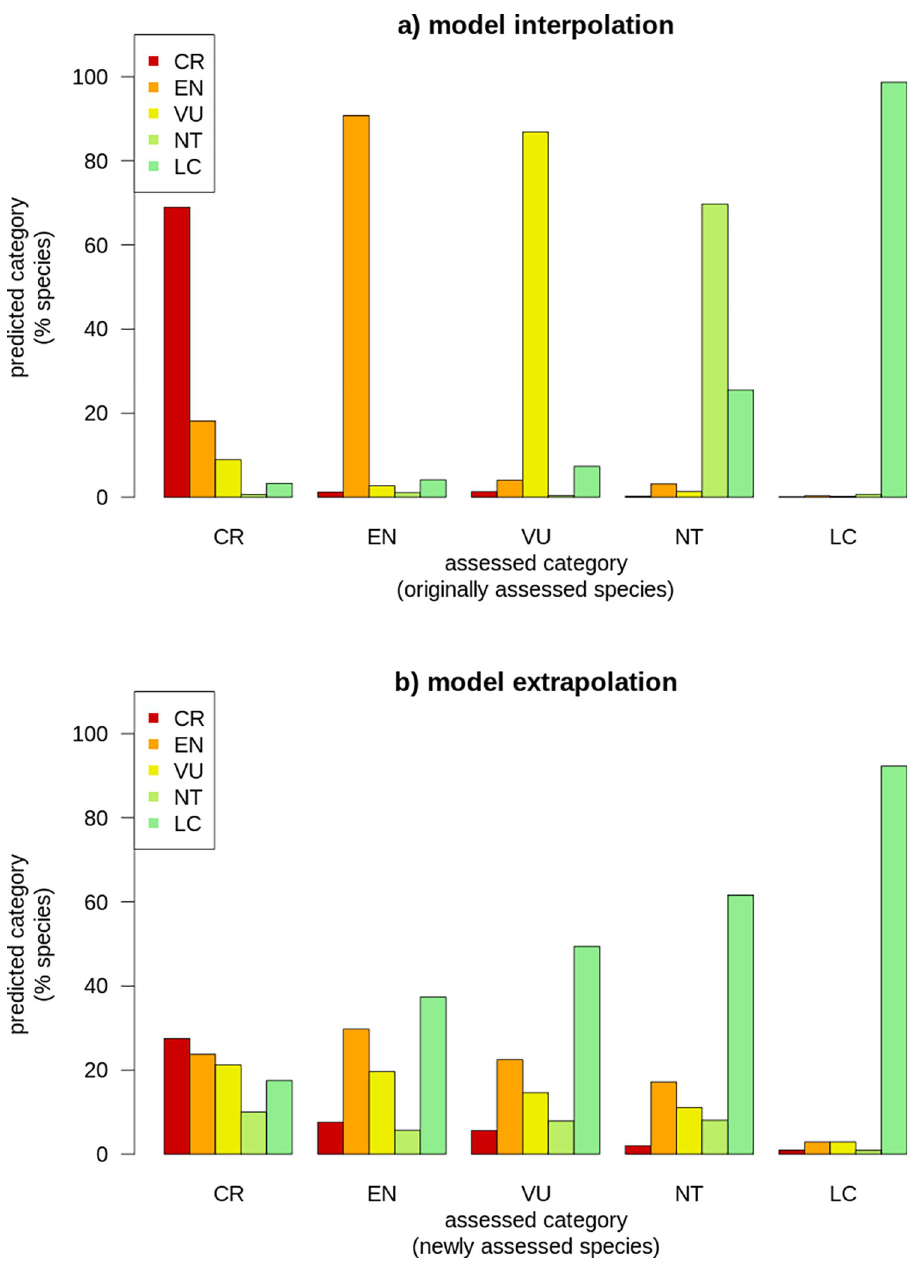
Fig 1. Comparison between the performance of the automated assessment model presented in [6] during interpolation and extrapolation. The bar plots report the contingency distribution between predicted Red List categories (y-axis, prediction) and assessed categories (x-axis, observation). Plot (a) reports the contingency between assessed versus predicted categories for 6,520 species used to train the automated assessment model in [6]. Plot (b) reports the contingency between assessed versus predicted categories for 1,463 species that were considered unassessed and not used for model training in [6] and were only assigned a Red List category in 2021 [9]. For this latter comparison, I only selected species having precise taxonomic correspondence with the latest release of the IUCN Red List database and being assigned a category of risk (see S1 Table), as follows: CR, critically endangered; EN, endangered; LC, least concern; NT, near threatened; VU,